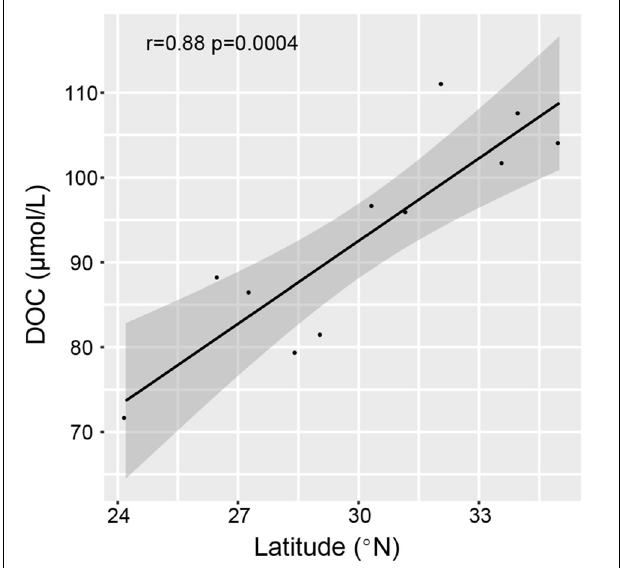
FIGURE 7 | The correlation between DOC contents and latitude among stations as shown by the Pearson